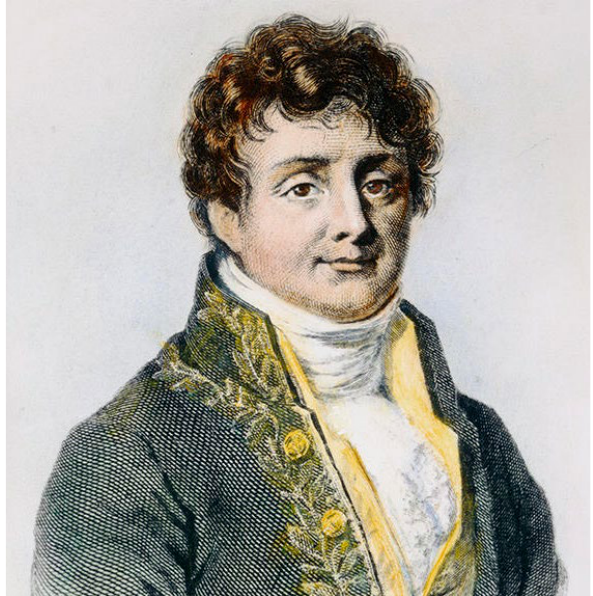
Figure 1. Joseph Fourier (1768–1830); Credit: www.bridgeman